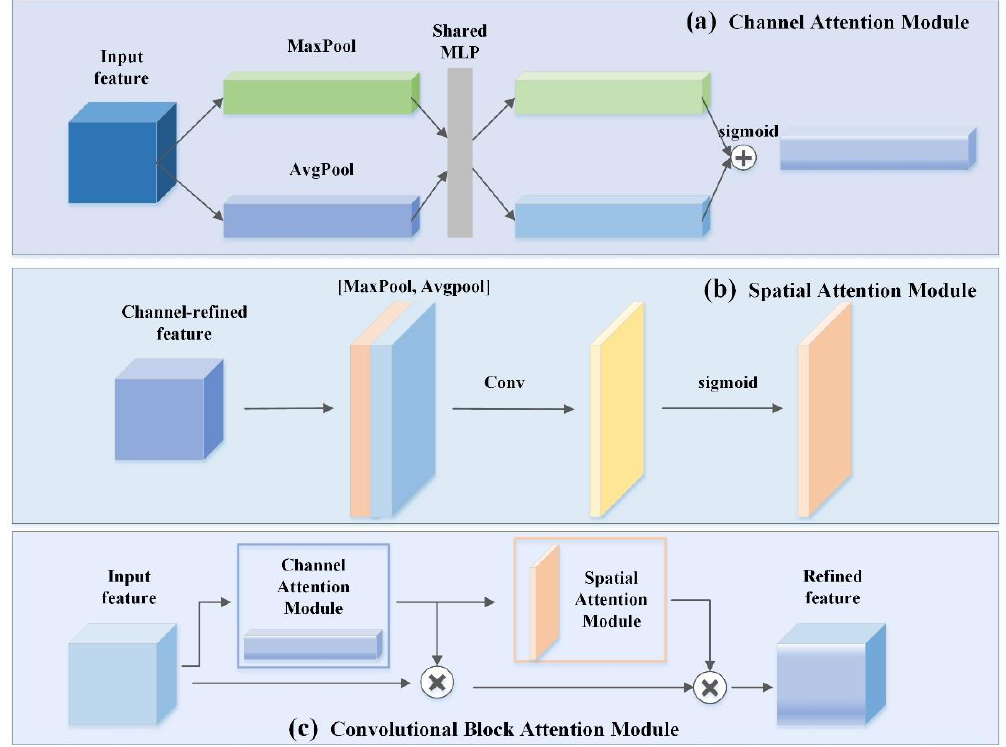
Figure 7. The overview of the CBAM and related attention module.